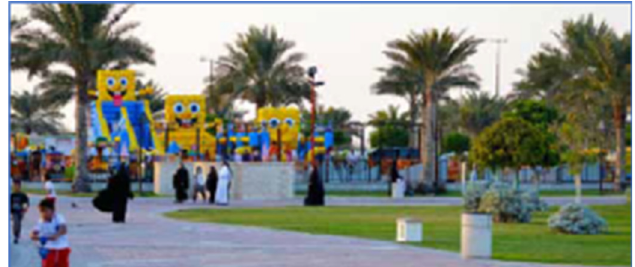
Fig. 4. The project provides 24 hours daily walking and sports